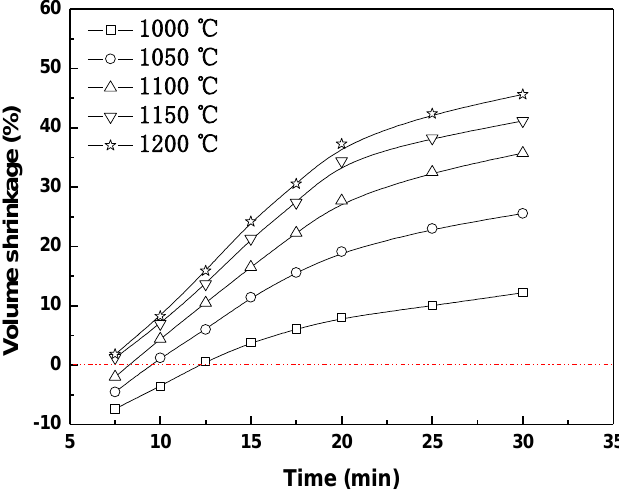
Figure 6. Volume shrinkage of the carbon composite pellets during reduction.